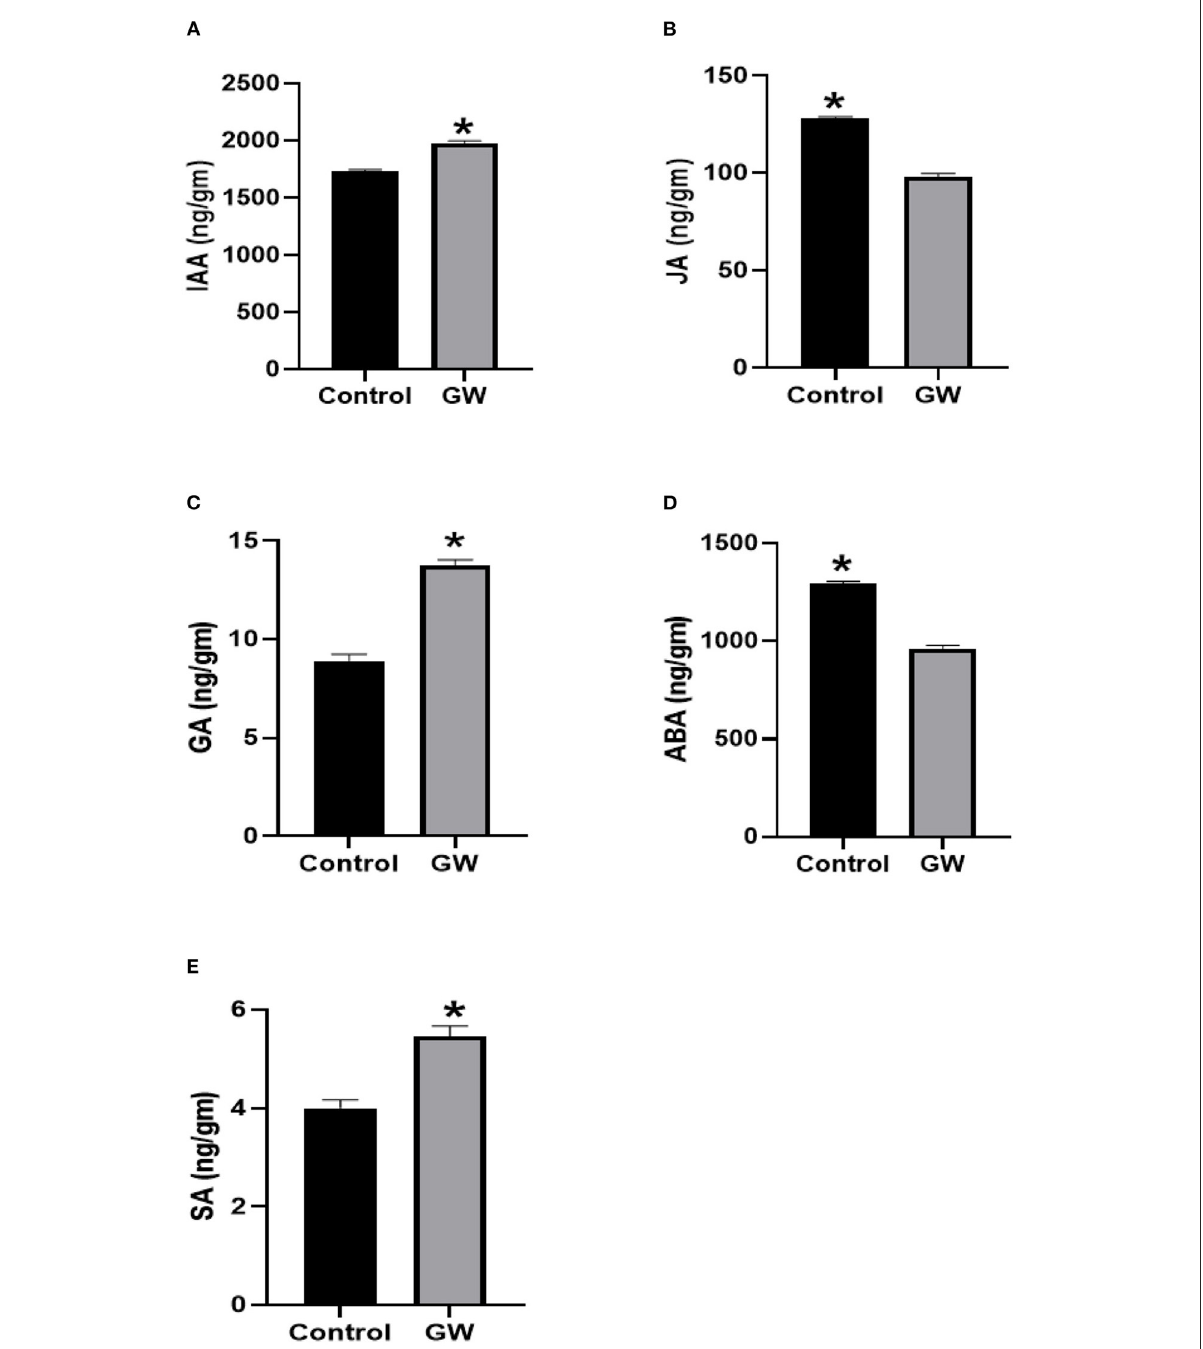
FIGURE11 Determination of different phytohormones (A) IAA, (B) JA, (C) GA, (D) ABA, and (E) SA in wheat seedlings inoculated with the endophytic fungus Fusarium oxysporum GW. Wheat seedlings were grown for 21 days in autoclaved soil inoculated with fungal biomass. Bars shows the mean of three replicates with standard deviation. Bars labeled with * are significantly higher ( t -test; p < 0.05).